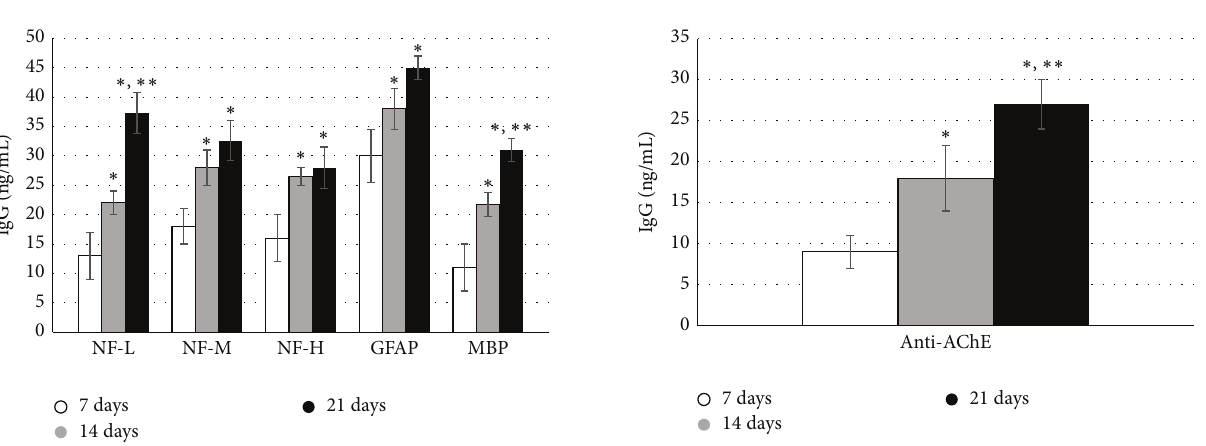
Table 3: Pearson’s correlation coefficients for antineurofilament IgG titers and changes in gait length and width of hens monitored for 21 days ∗ .